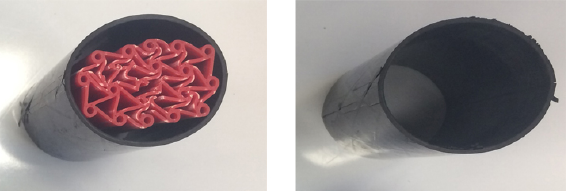
Figure 14. Deformed chiral-lattice-filled ( left ) and hollow ( right ) composite tubes under lateral